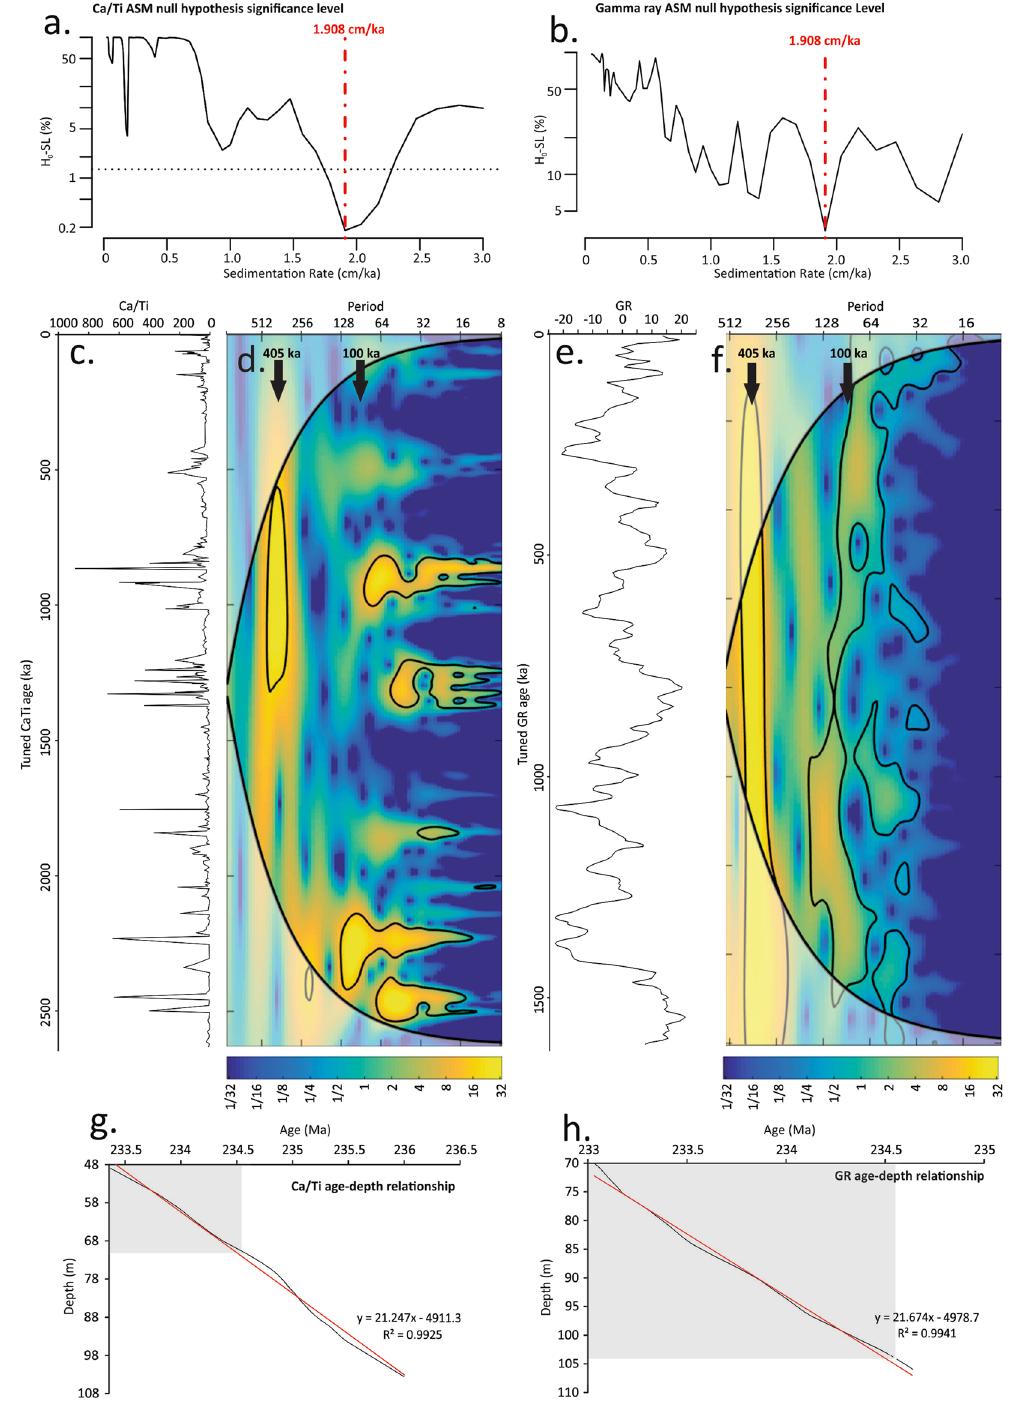
Figure 3. Time series analysis of the Ca/Ti XRF data (all data) and GR data spanning the DMF. ( a ) Sedimentation rate null hypothesis significance levels for Ca/Ti data through the DMF, note the most likely sedimentation rate is 1.908 cm ka -1 . ( b ) Sedimentation rate null hypothesis significance levels for GR data through the DMF, note the most likely sedimentation rate is 1.908 cm ka -1 . ( c ) Tuned Ca/Ti data on the 405 ka cycle. ( d ) Wavelet analysis applied on the tuned Ca/Ti dataset. ( e ) Tuned GR data on the 405 ka cycle. ( f ) Wavelet analysis applied on the tuned GR dataset. Pale areas delineate the cone of influence where the wavelet power is uncertain. ( g ) Age-depth relationship for WP borehole 1 (Ca/Ti) derived from tuning to the 405 ka cycle. ( h ) Age-depth relationship for WP borehole 2 (GR) derived from tuning to the 405 ka cycle. Note grey box highlights the DMF in both age-depth plots. The equation in g. is used to construct the floating chronology for the δ 13 C wax and δ 13 C TOC in Fig.